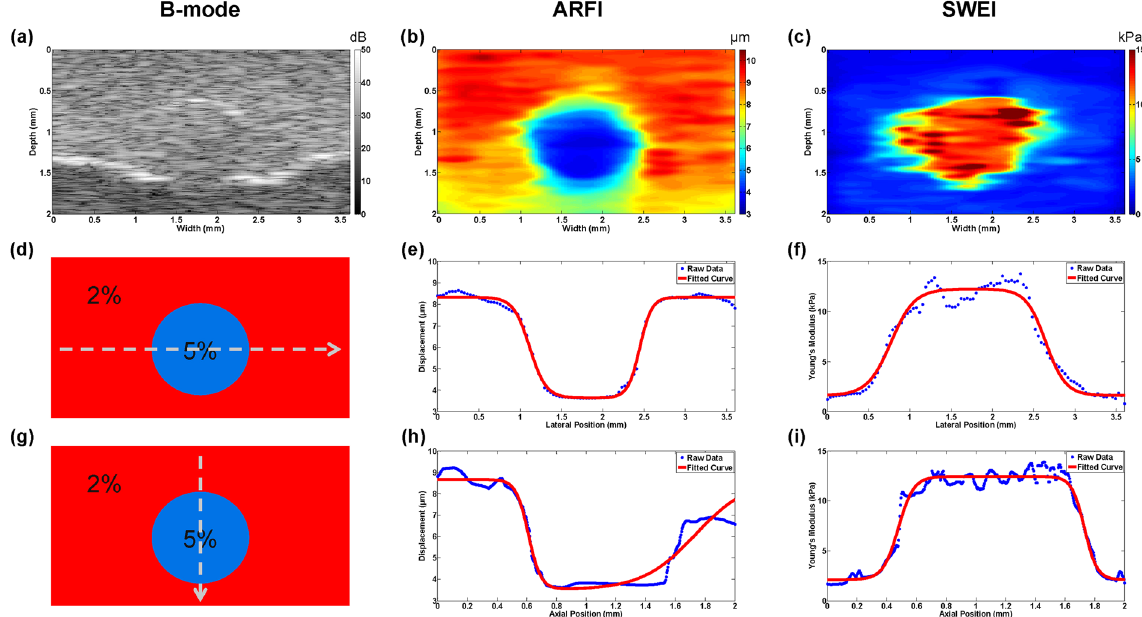
Figure 3. Inclusion phantom imaging results and transitional curve profiles. ( a – c ) 2D cross-sectional B-mode image, ARFI image and SWEI image. The data profiles ( d ) at a depth of 1.1 mm and ( g ) at a width of 1.8 mm were selected. The raw data and fitted curve of ARFI and SWEI were plotted along ( e , f ) lateral direction, and ( h , i ) axial direction. The phantom has a 1.2 mm diameter cylindrical inclusion with a background-interior- background